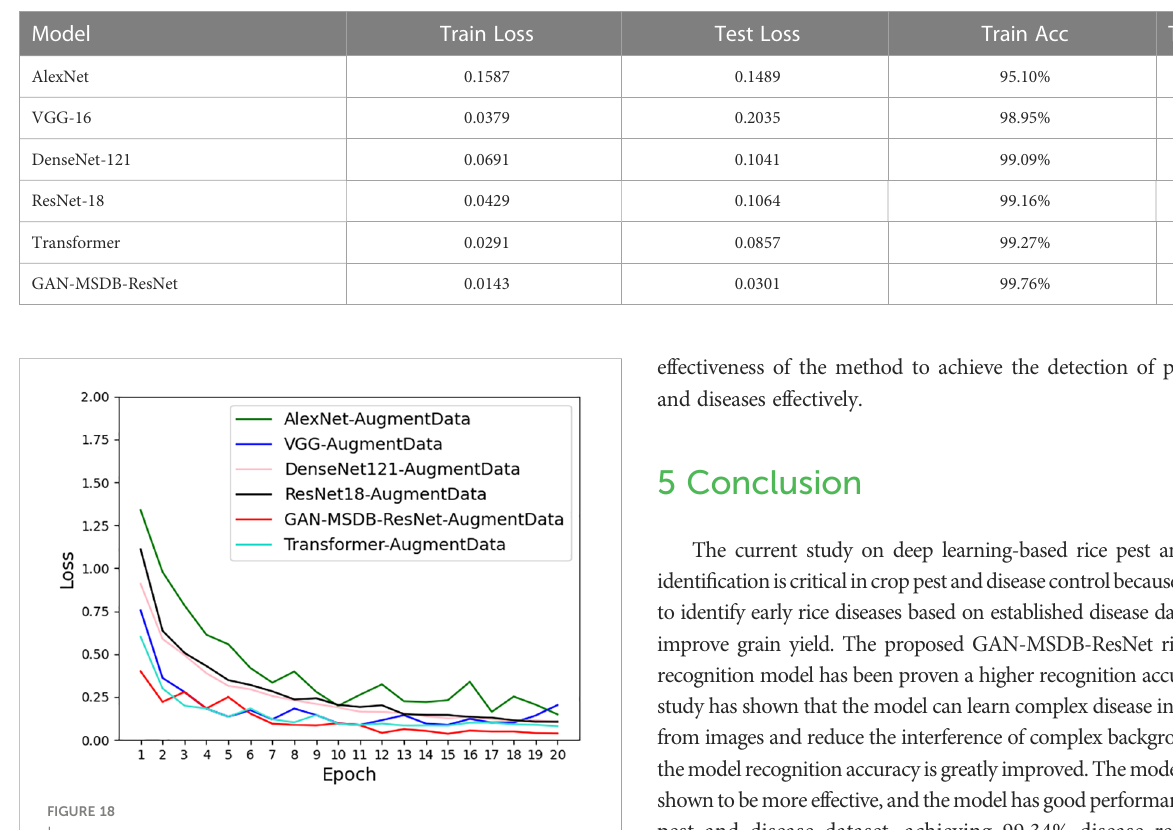
FIGURE 18 Loss curve.